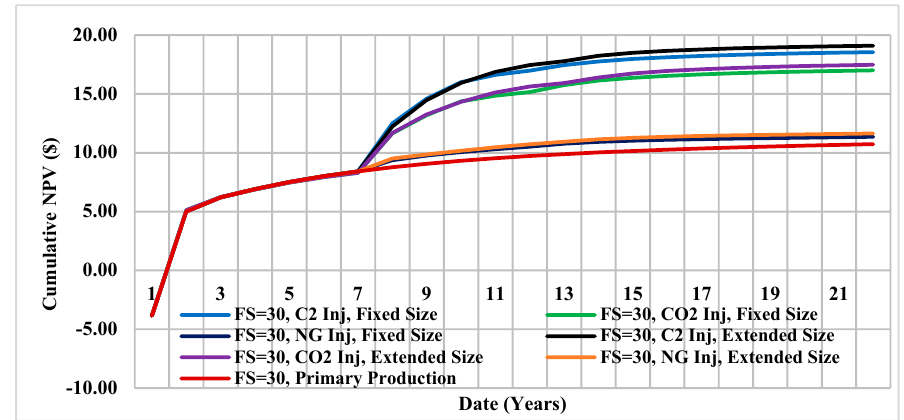
well as natural depletion, FS=30, Oil API=31.